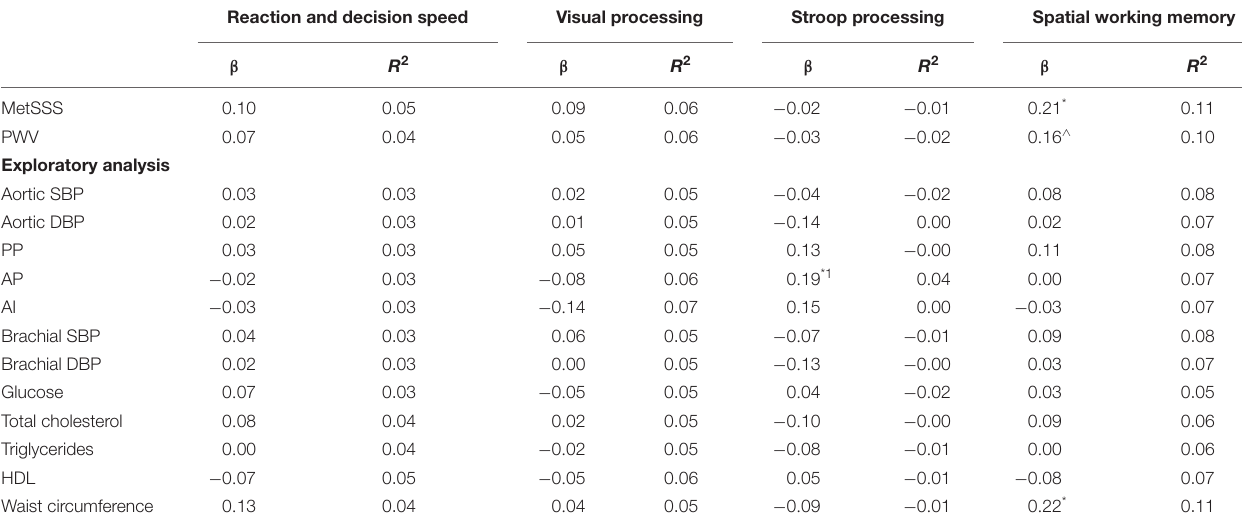
TABLE 5 | Association of cardio-metabolic measures with cognitive performance, standardized coefficients beta, and adjusted R -Square. Reaction and decision speed Visual processing Stroop